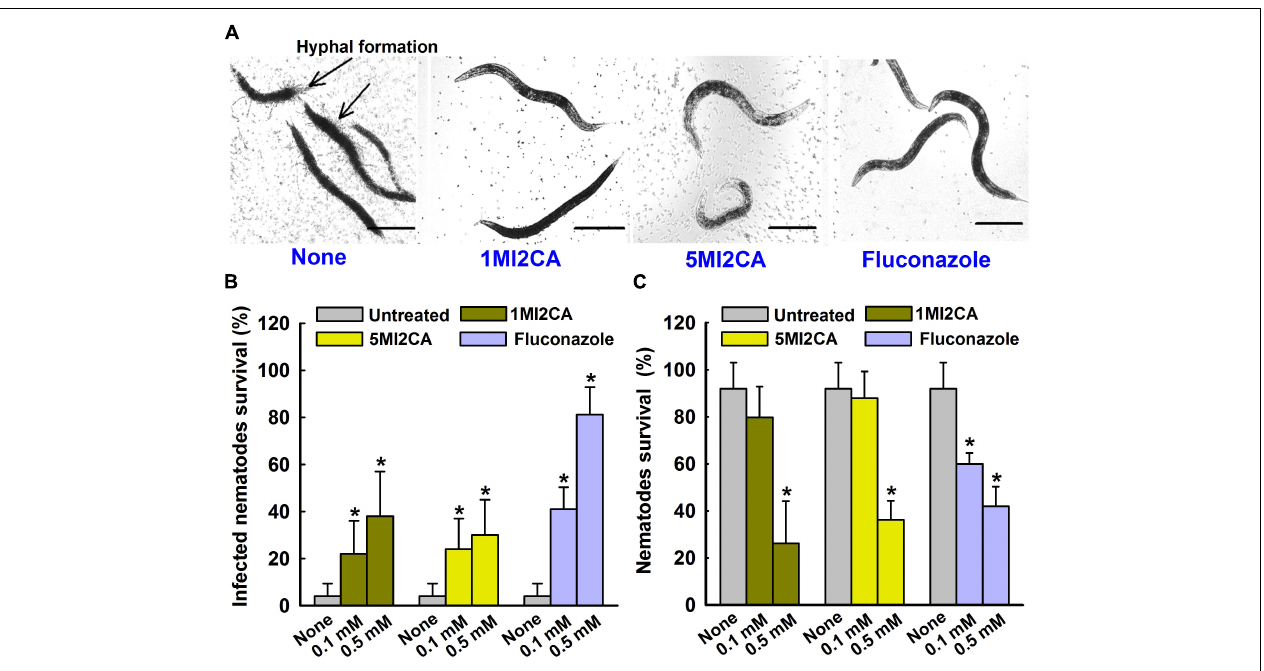
FIGURE 6 | Effects of methylindoles on C. albicans virulence in the model of C. elegans . Microscopic images of C. albicans infected C. elegans in absence or presence of methylindoles (0.5 mM) or fluconazole as a positive control (0.1 mM) (A) . The arrows indicate hyphal formation in untreated infected nematodes and the scale bar represents 100 µ m. The bar graph shows nematode percentage survival after exposure of C. albicans for 4 days to methylindoles (0.1 or 0. 5 mM) (B) . The toxicities of 1MI2CA and 5MI2CA were studied on non-infected nematodes by calculating survival rates after exposure for 4 days (C) . Fluconazole (0.1 or 0.5 mM) was used as the positive control. None indicates untreated controls. Worm survival was determined based on movement. At least two independent experiments were conducted. Error bars indicate standard deviations. ∗ p < 0.05 vs. untreated controls.